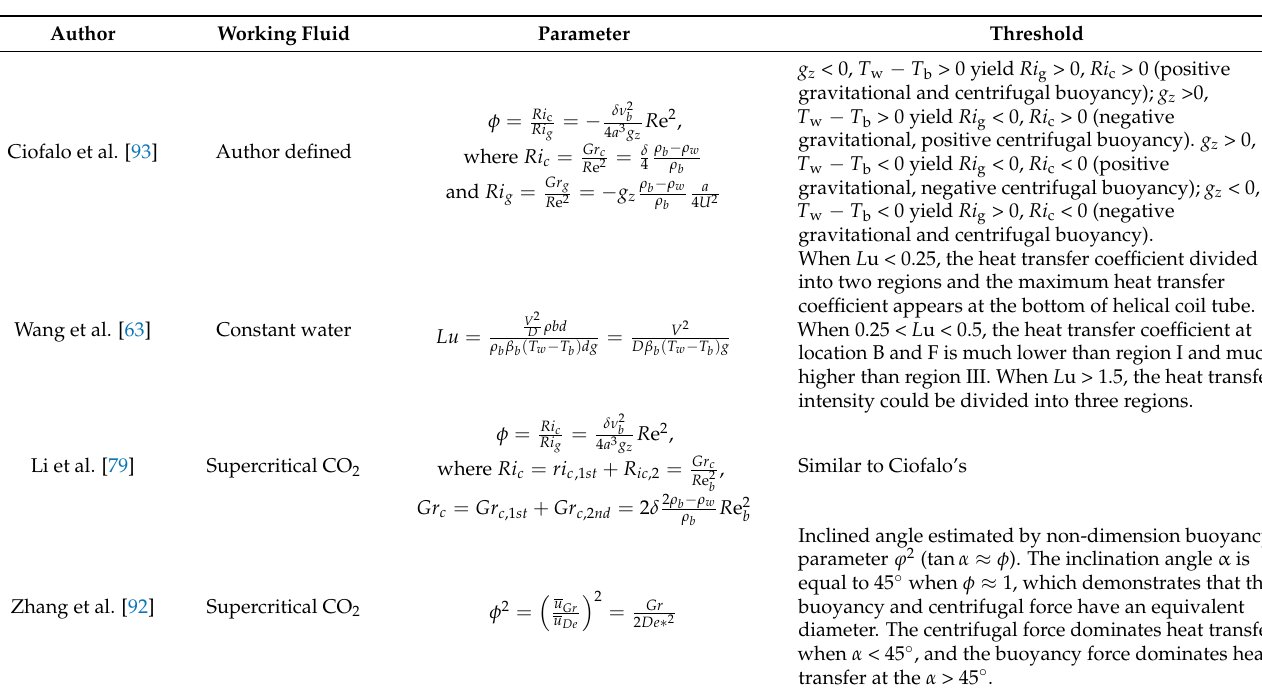
Table 3. Summary of the proposed dimensionless parameter to determine the relative strength of buoyancy force and centrifugal